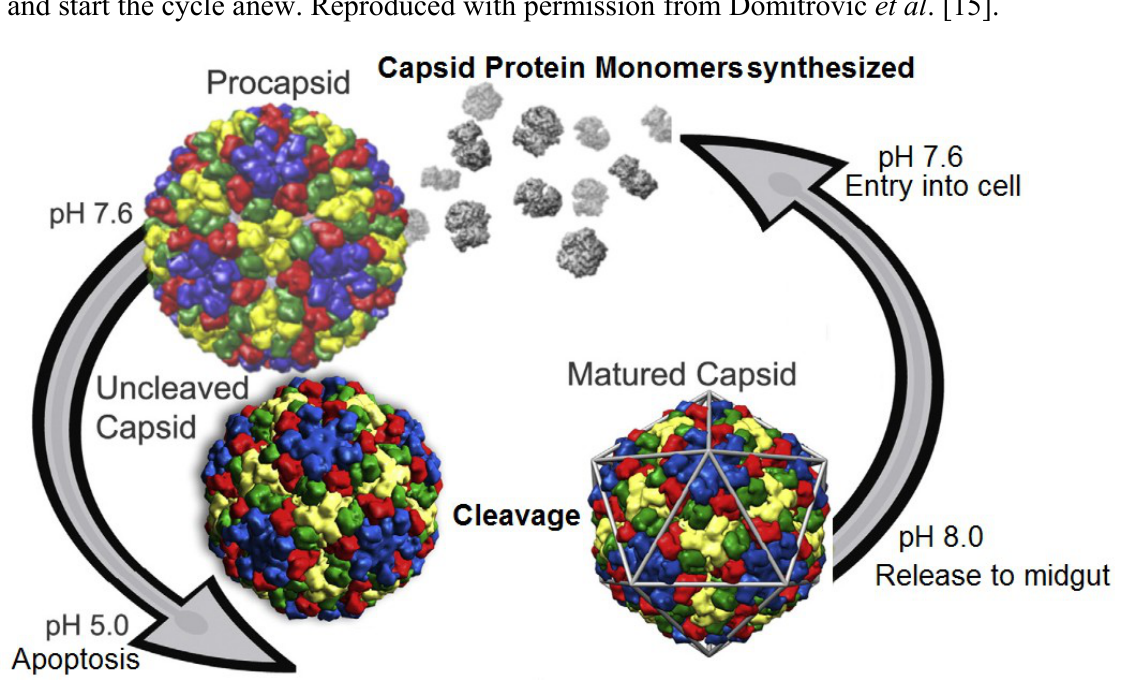
Figure 3. Life cycle of tetraviruses. Infected cells produce procapsids at relatively neutral pH. Production of virus particles eventually triggers apoptosis which induces a drop in pH and virus maturation. Release to the alkaline midgut allows the virus to further infect cells and start the cycle anew. Reproduced with permission from Domitrovic et al .